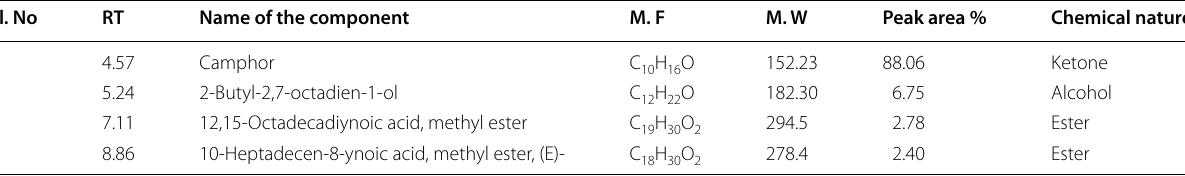
Table 1 GC–MS spectral analysis of ethanolic extract of L. rugosa